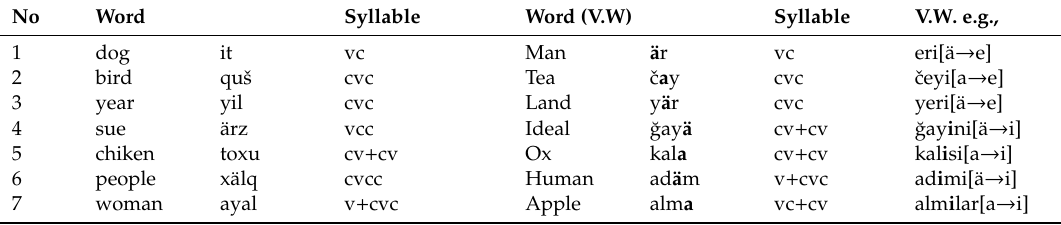
Table 1. Experimental words and syllable structure attributes in type A